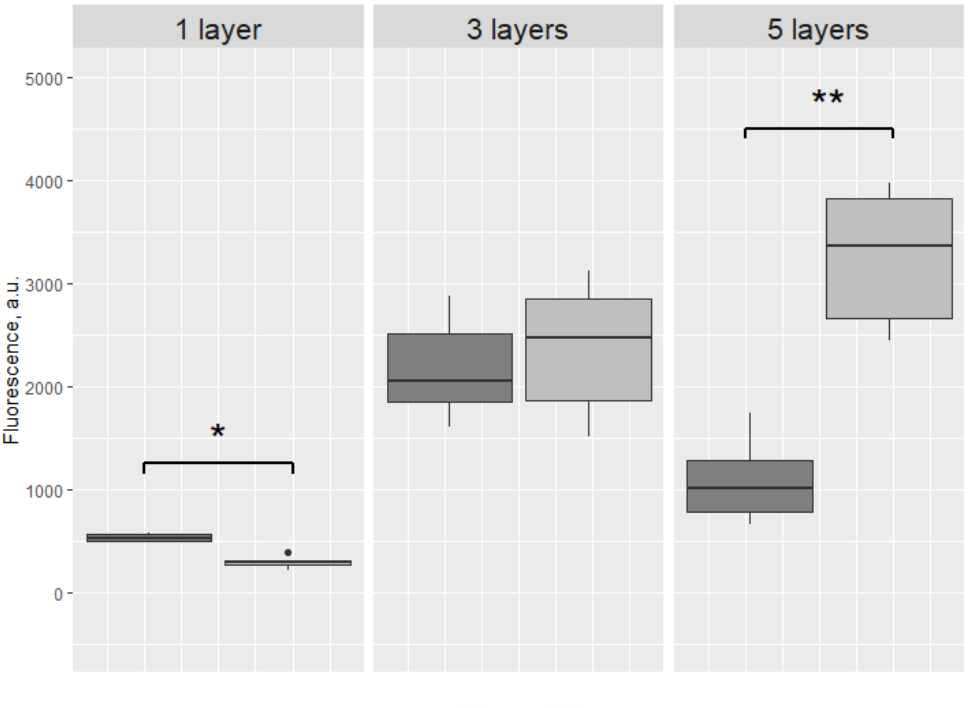
Figure 3. Box plot of the fluorescence intensity after 72 h of incubation of cell-loaded scaffolds (hy- drogel with BC cells) and control scaffolds (hydrogel only) printed in one, three or five layers. * p < 0.01.